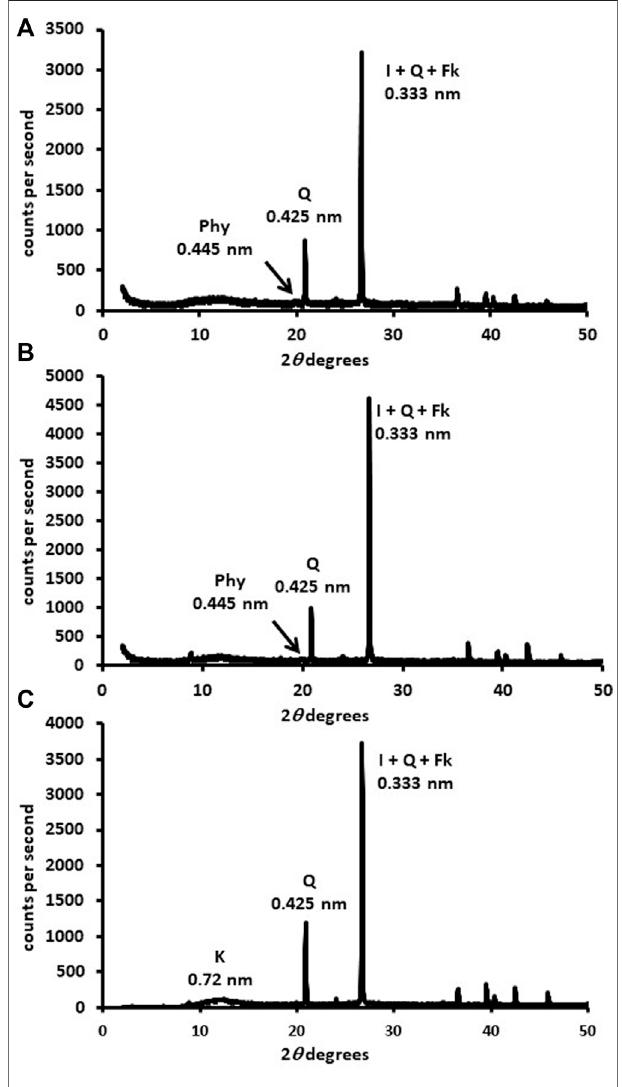
FIGURE 1 | DRX mineralogical composition of the fi ne-earth fraction ( < 2 mm; DRX-disoriented powder) in the 0 – 50 ° 2 θ . (A) forest sample, (B) organic sample, (C) conventional sample. Phy: phyllosilicates, I: illite, Q: quartz, Fk: potassium feldspar, K: kaolinite.